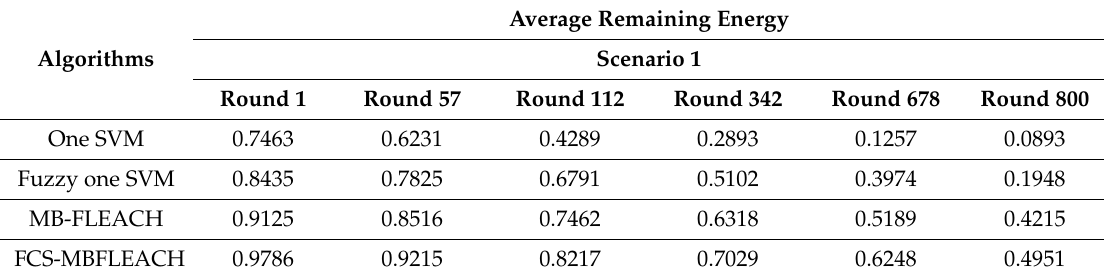
Figure 16. Average remaining energy for fault detection methods in di ff erent rounds for the second scenario. Table 2. Average remaining energy in di ff erent rounds for the first scenario.